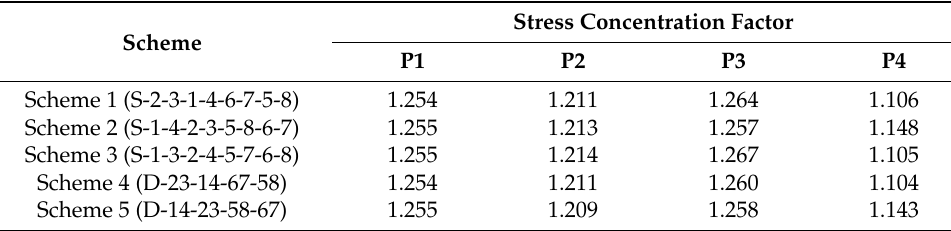
Table 2. Stress concentration factors for schemes 1 to 6 on each monitoring plane.